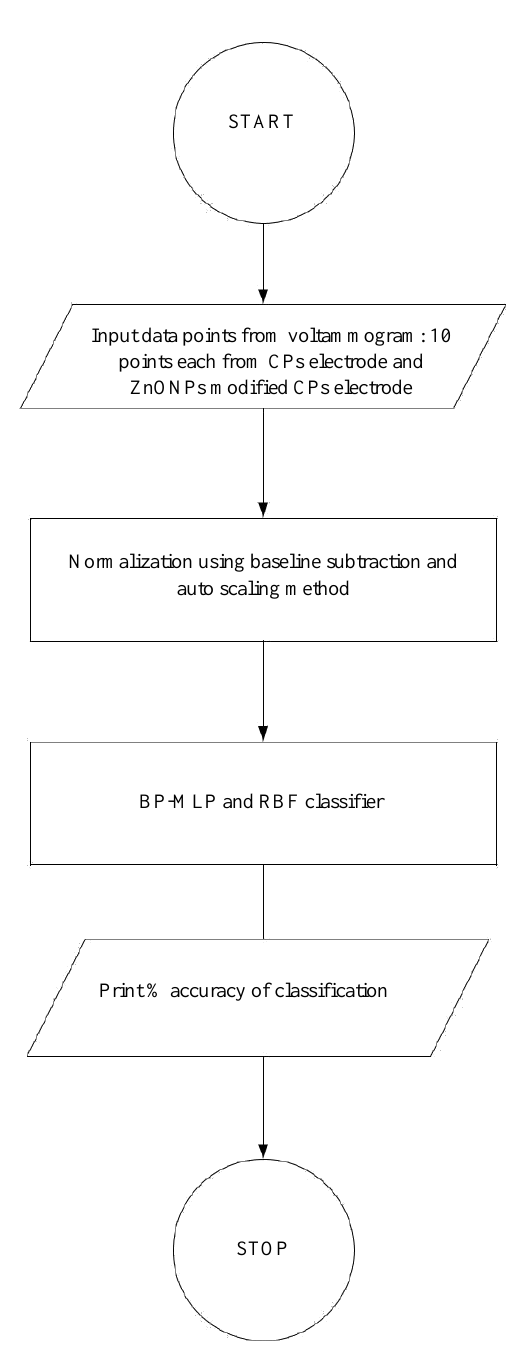
Figure 4. Flowchart for data analysis using neural networks, i.e. the input layer consists of the first 10 principal components and the five output nodes correspond to five floral types of